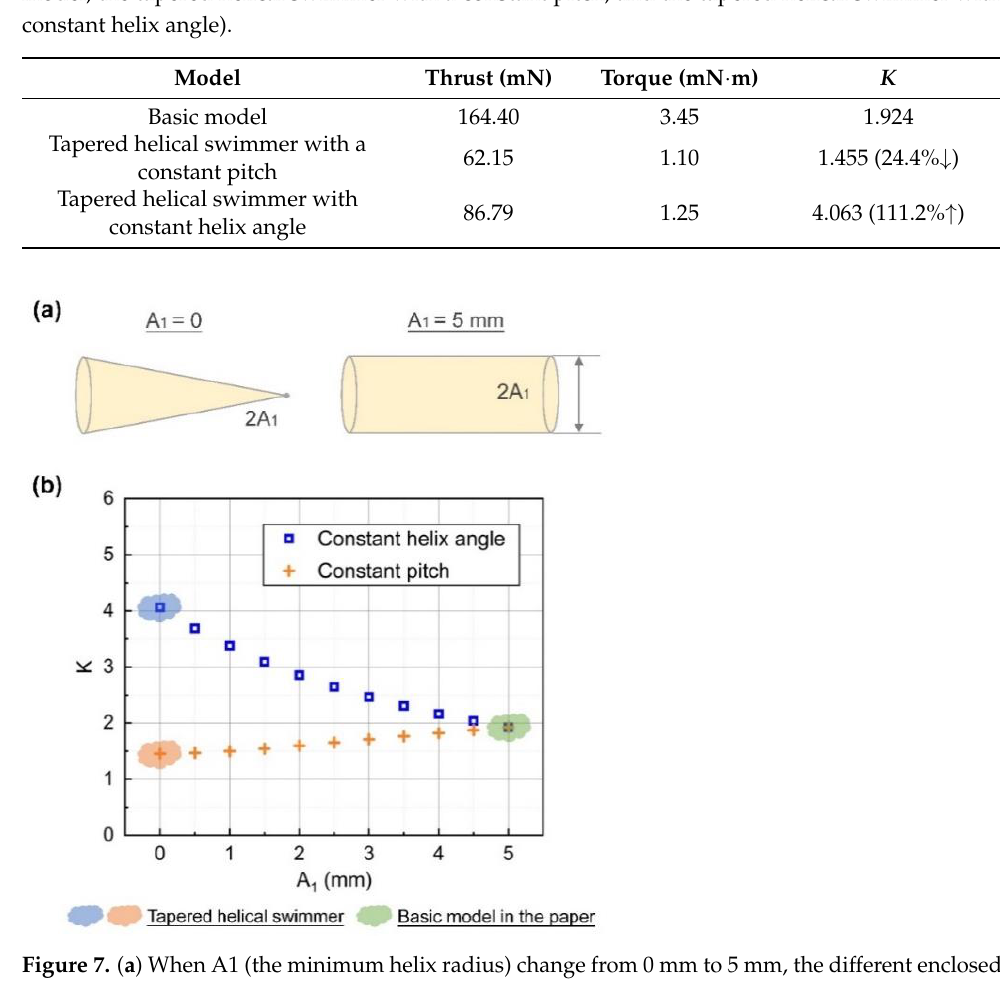
Table 1. The three propulsion performance indexes (thrust, torque, and K ) of three models (basic model, the tapered helical swimmer with a constant pitch, and the tapered helical swimmer with constant helix angle).